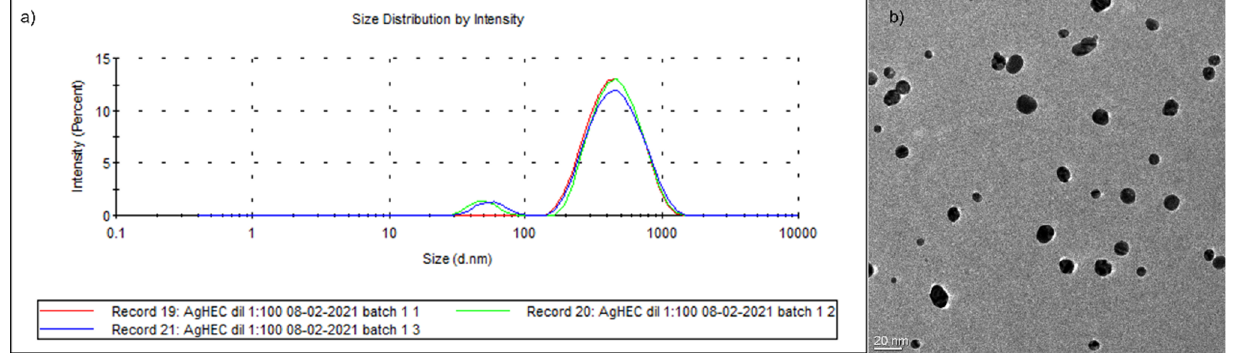
Figure 2. ( a ) Particle size distribution and ( b ) TEM image of AgHEC NPs.